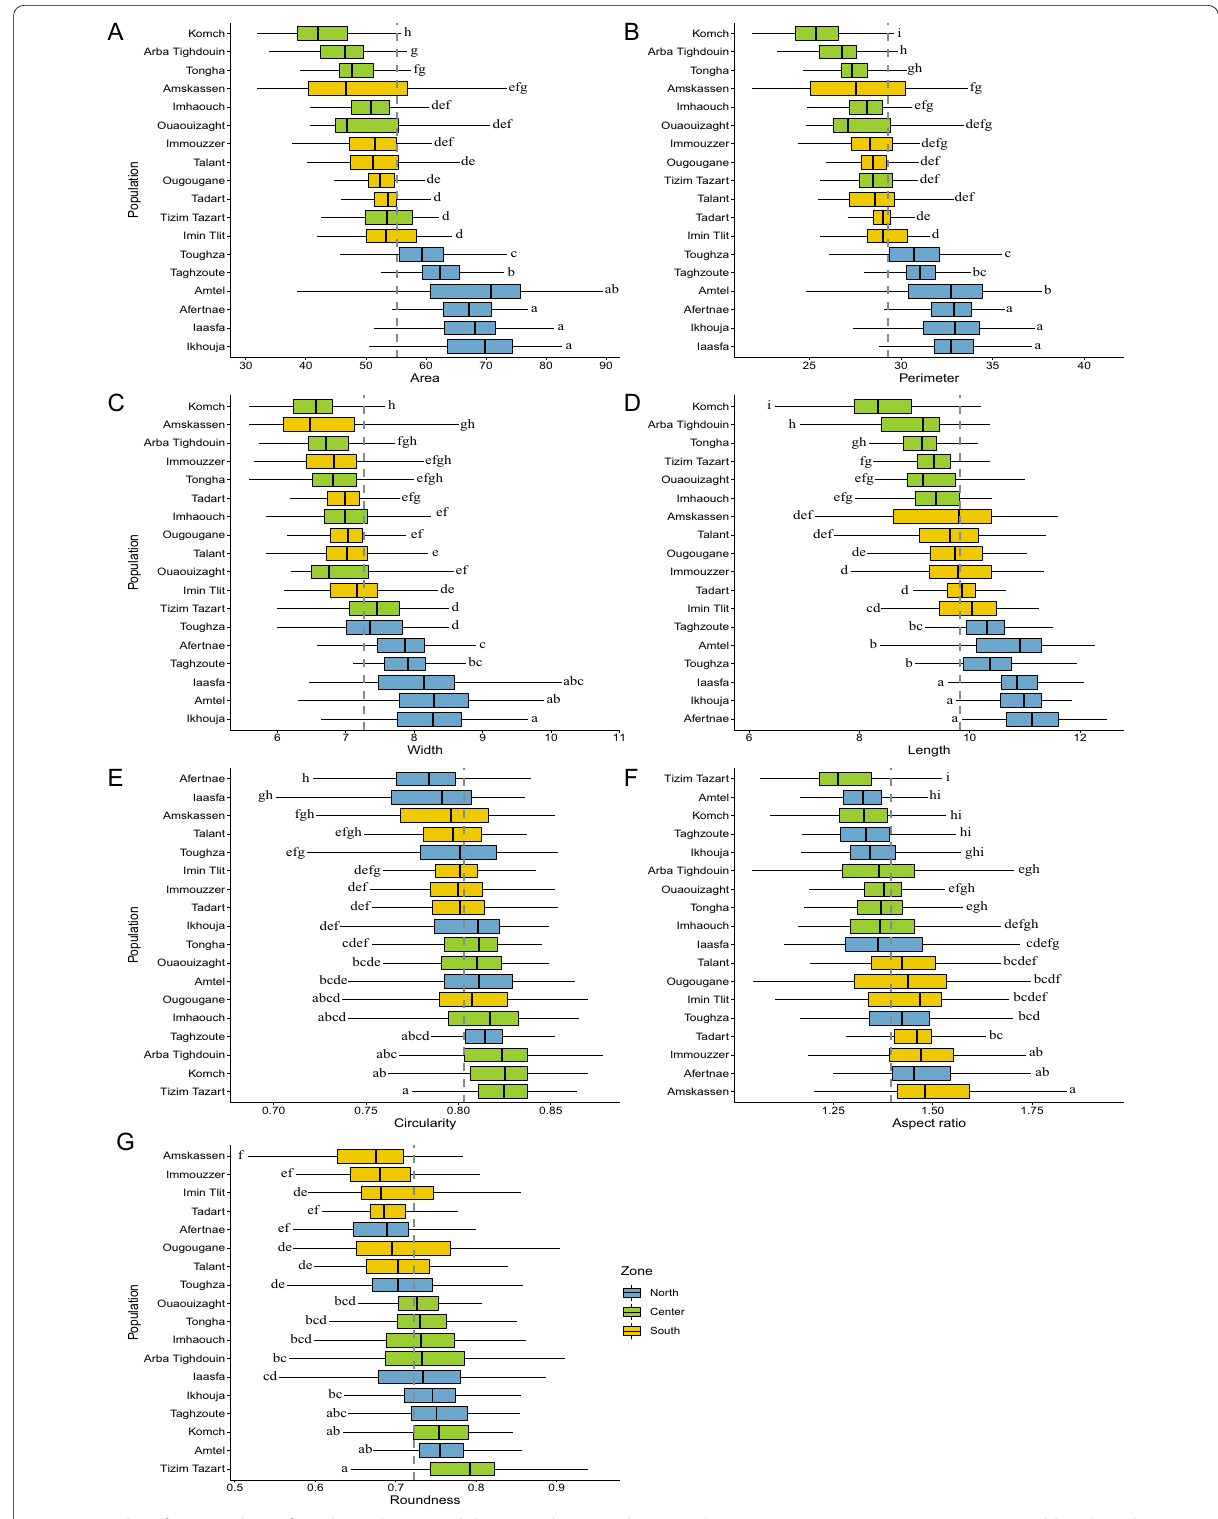
Fig. 1 Boxplot of mean values of carob seed traits and their population and geographic provenances. A area, B perimeter, C width, D length, E circularity, F aspect ratio, G roundness. Levels connected by the same letter are not statistically different at P < 0.05 in Tukey HSD post hoc tests. Dashed lines represent the general mean value of the